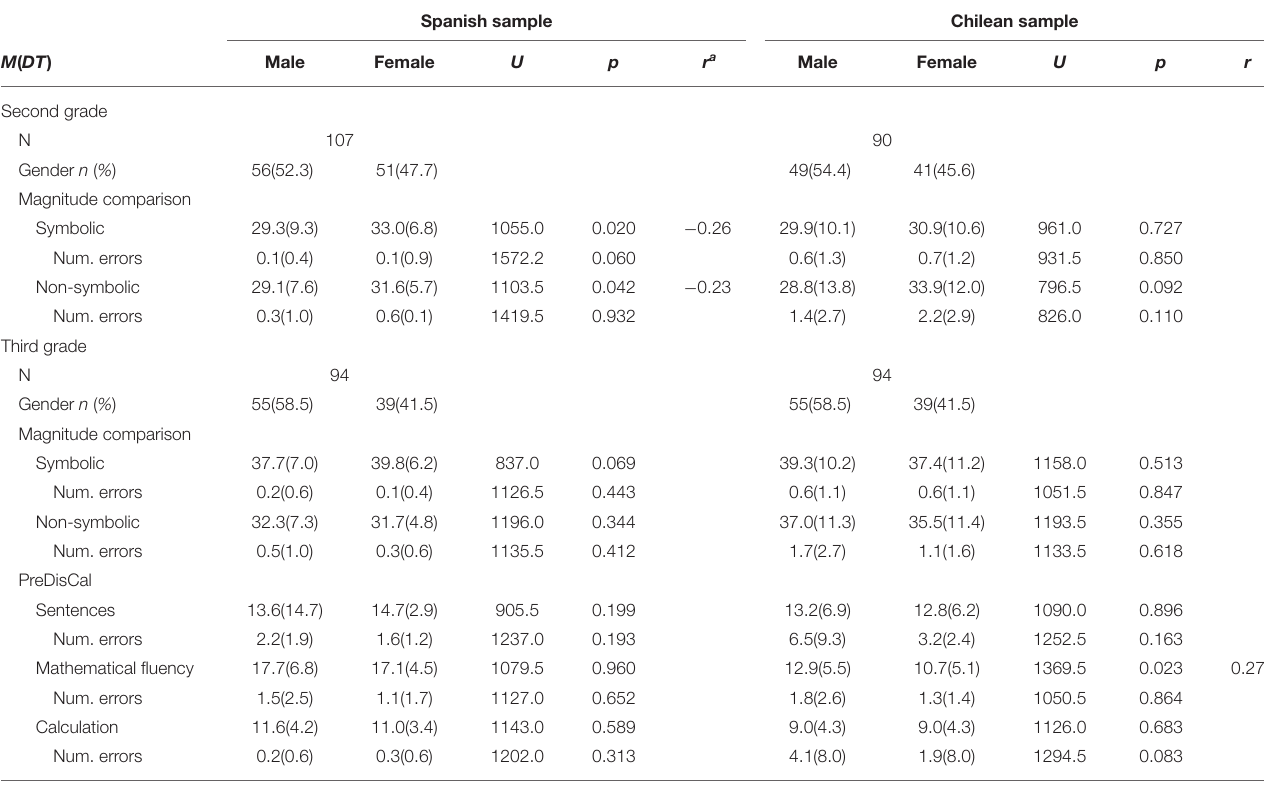
TABLE 1 | Distribution in the Spanish language sample of second and third graders: scoring on symbolic test by gender. Spanish sample Chilean